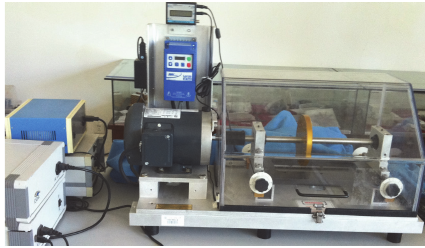
Figure 12: Rolling bearing fault test platform.